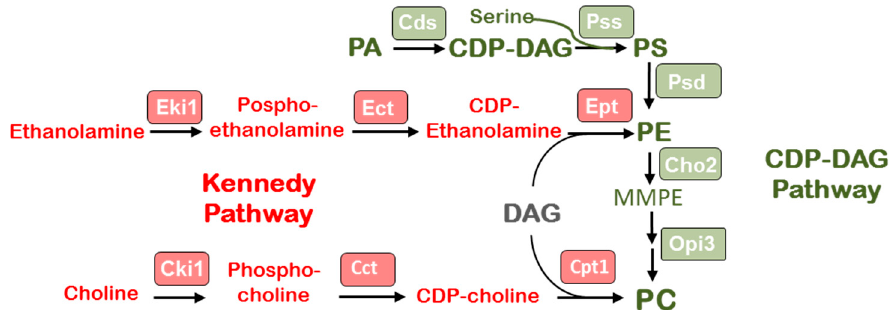
Figure 4. The scheme of phospholipid metabolism in fungi.